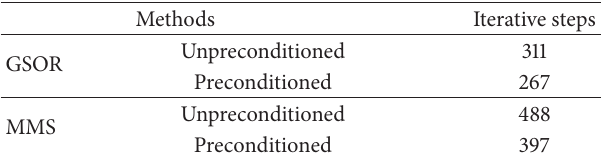
Table 1: Comparison of MMS and GSOR with unpreconditioned and preconditioned